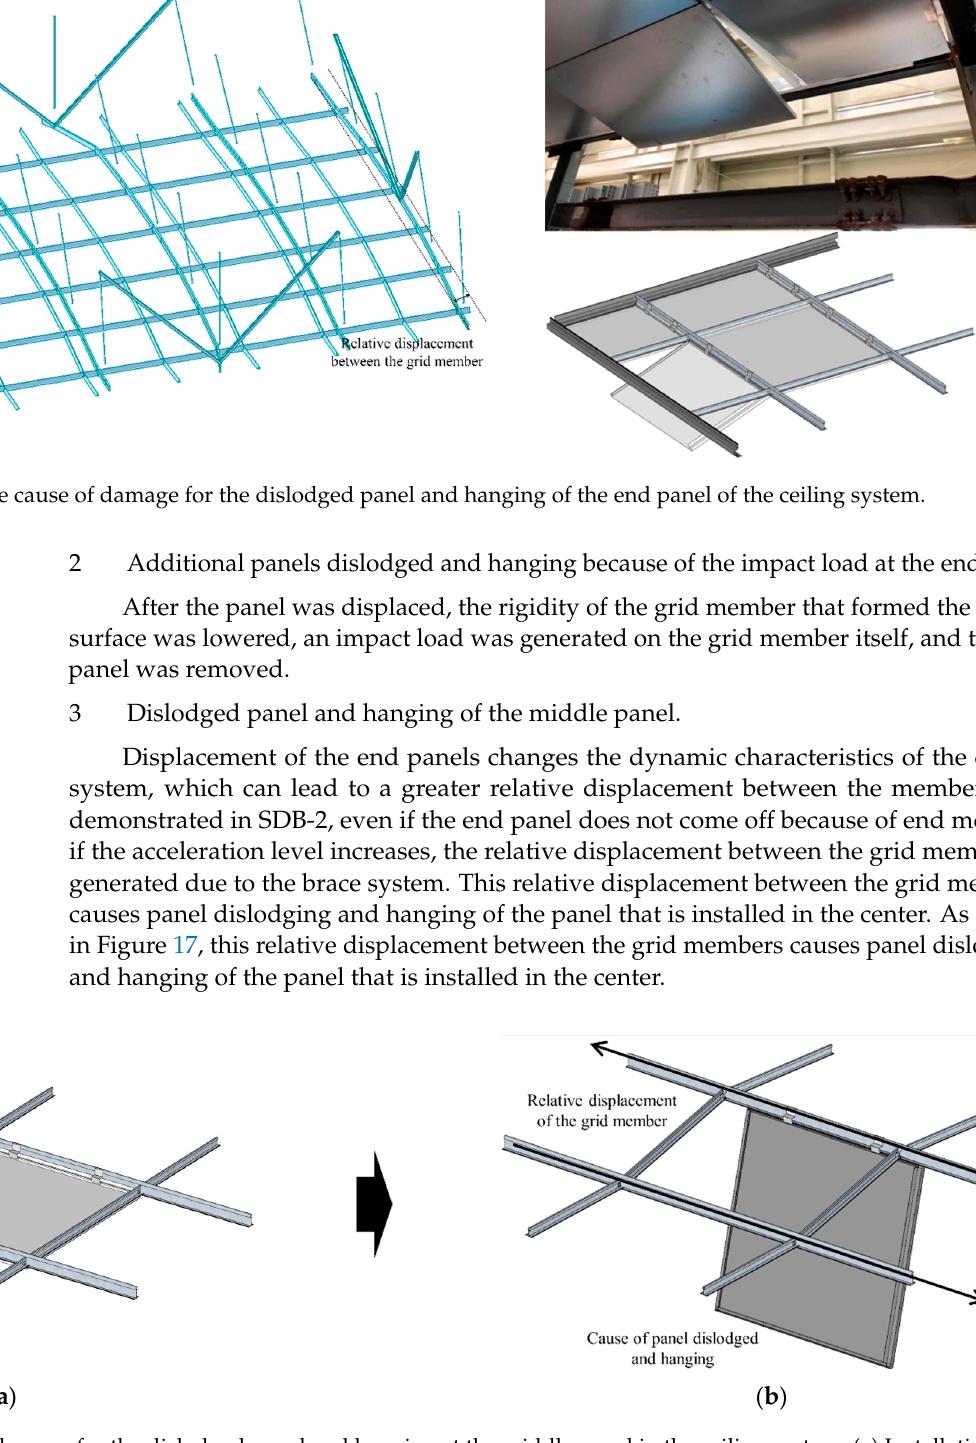
( b ) Figure 18. Cause of damage for the panel falling. ( a ) Panel dislodged and hanging because of the relative displacement of the grid member. ( b ) Failure of the anti-falling clip due to the impact. 3.5. Performance Evaluation of the Indirect Suspended T-Bar Ceiling System with the Steel Panel Table 7 shows the performance levels of the two brace-applied specimens that were used in this study. This was achieved by using the damage state and the performance level of the indirect suspended ceiling system with a steel panel to which the anti-falling clip was applied, as shown in Table 4 in Section 3.2. In addition, the analysis was performed